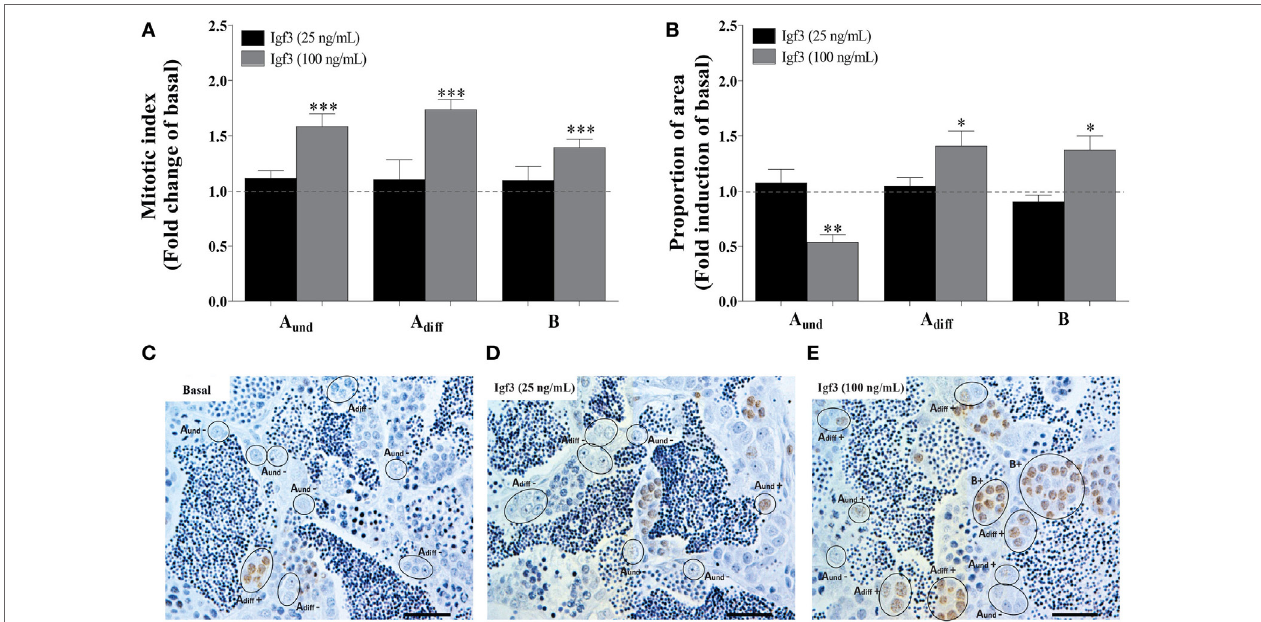
FigUre 4 | Effect of 25 or 100 ng/mL Igf3 on spermatogonial proliferation and proportion of area after 3 days of primary testis tissue culture. (a) Mitotic index of type A und , type A diff , and type B spermatogonia in the presence of 25 ng/mL (black bars) ( n = 6) or 100 ng/mL Igf3 (gray bars) ( n = 7). (b) Proportion of section surface area occupied by cysts containing type A und , type A diff , or type B spermatogonia, following exposure to 25 ng/mL (black bars) ( n = 6) or 100 ng/mL Igf3 (gray bars) ( n = 7). (c–e) Immunocytochemical detection of BrdU in sections of zebrafish testis incubated under basal conditions (c) or in the presence of 25 ng/mL (D) or 100 ng/mL Igf3 (e) for 3 days, showing BrdU positive ( + ) and negative ( − ) A und , A diff , and B spermatogonia. Bars, 25 µm. Dotted lines in A and B represent the mean values of the control groups (absence of Igf3). Asterisks indicate significant differences (* P < 0.05; ** P < 0.01; *** P < 0.001) compared to the respective control